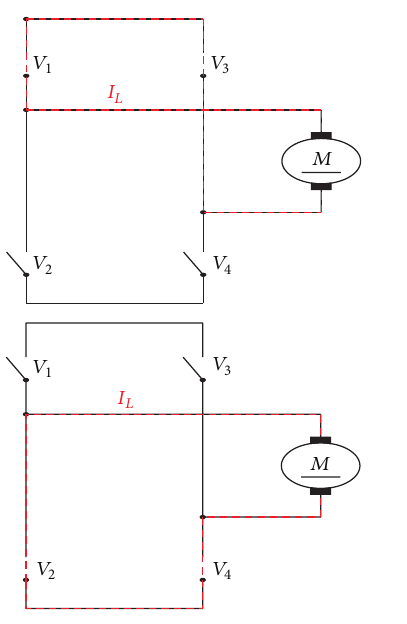
Figure 9: Working phase six (freewheeling).